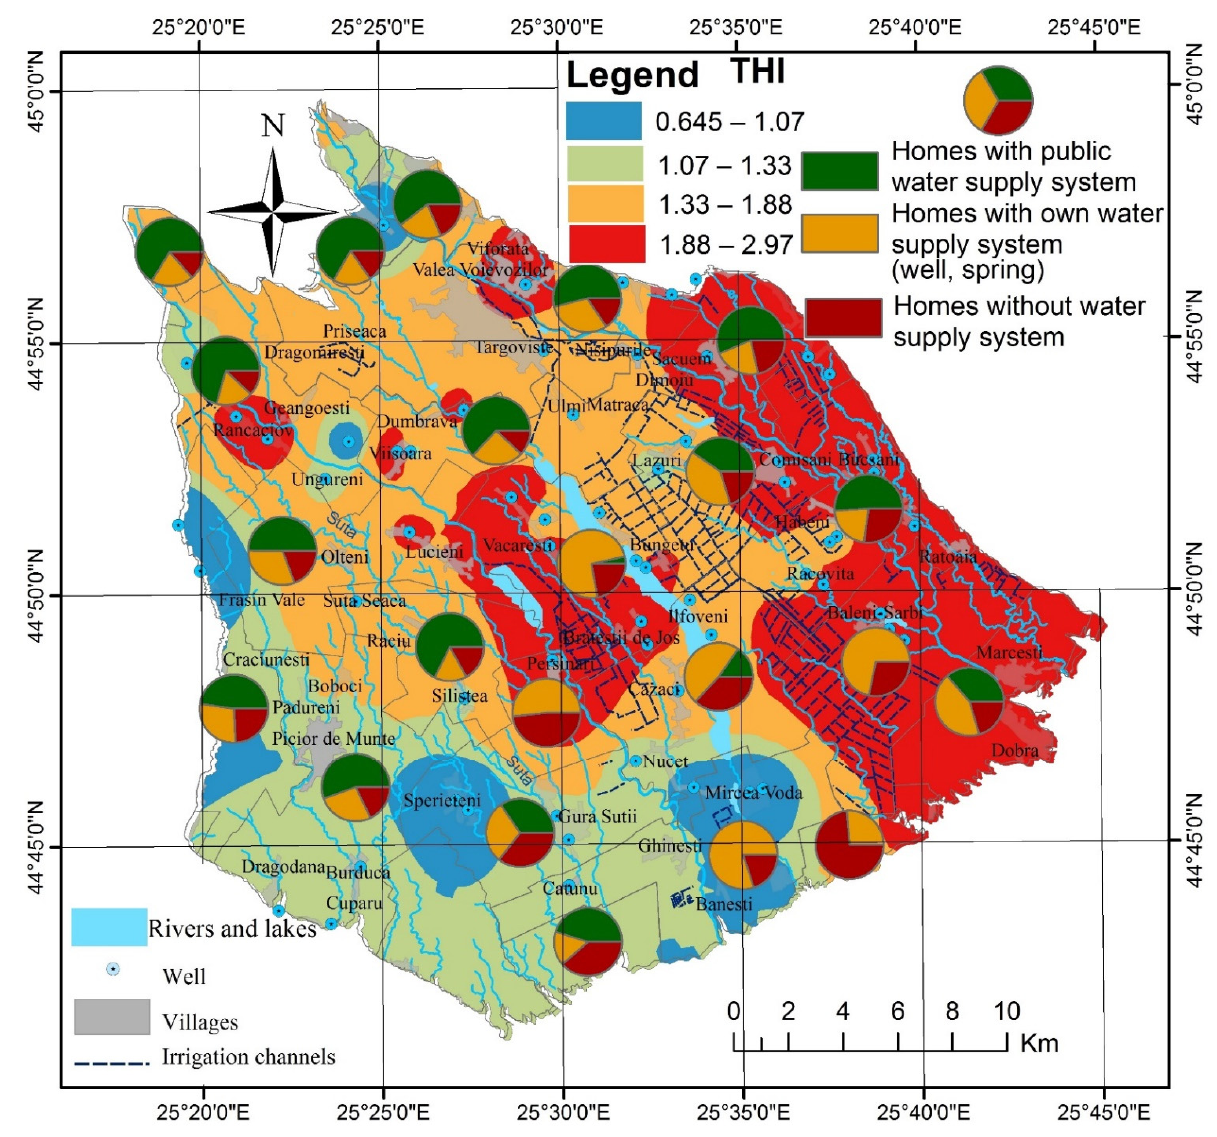
Figure 8. Spatial distribution of health risk (THI) in Târgovi ş te Plain. Table 7. THI and CCR values from T â rgovi¸ste